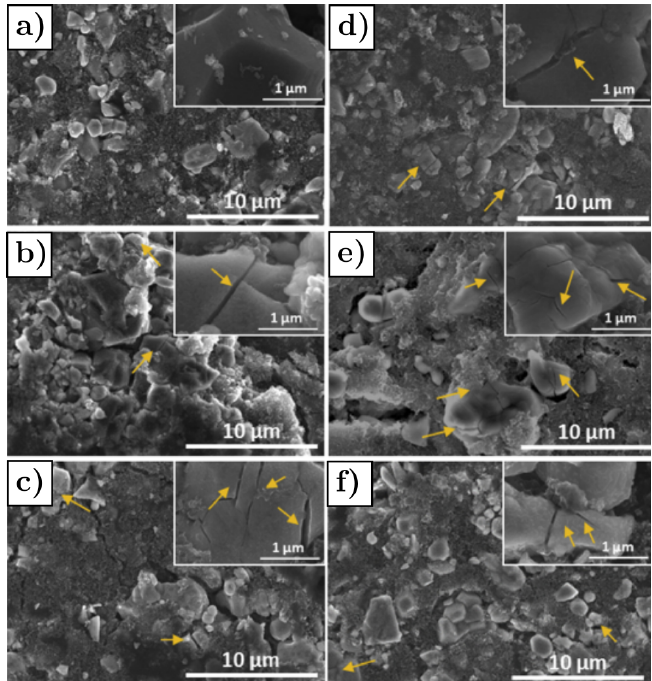
Figure 13. SEM images of the electrode structure ( a ) before cycling and after ( b ) 40 cycles, ( c ) 125 cy- cles, ( d ) 500 cycles, ( e ) cycled at low voltage to trigger Jahn-Teller transformation and ( f ) cycled at high temperature. Reprinted with permission by Elsevier from [88], Copyright